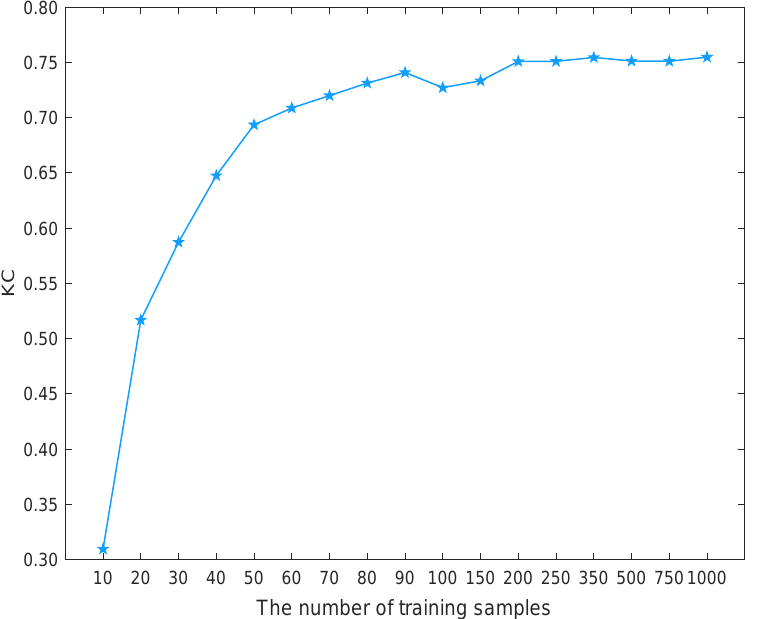
Figure 7. Relationship between the number of training samples and accuracy for the proposed ASSCDN on the River